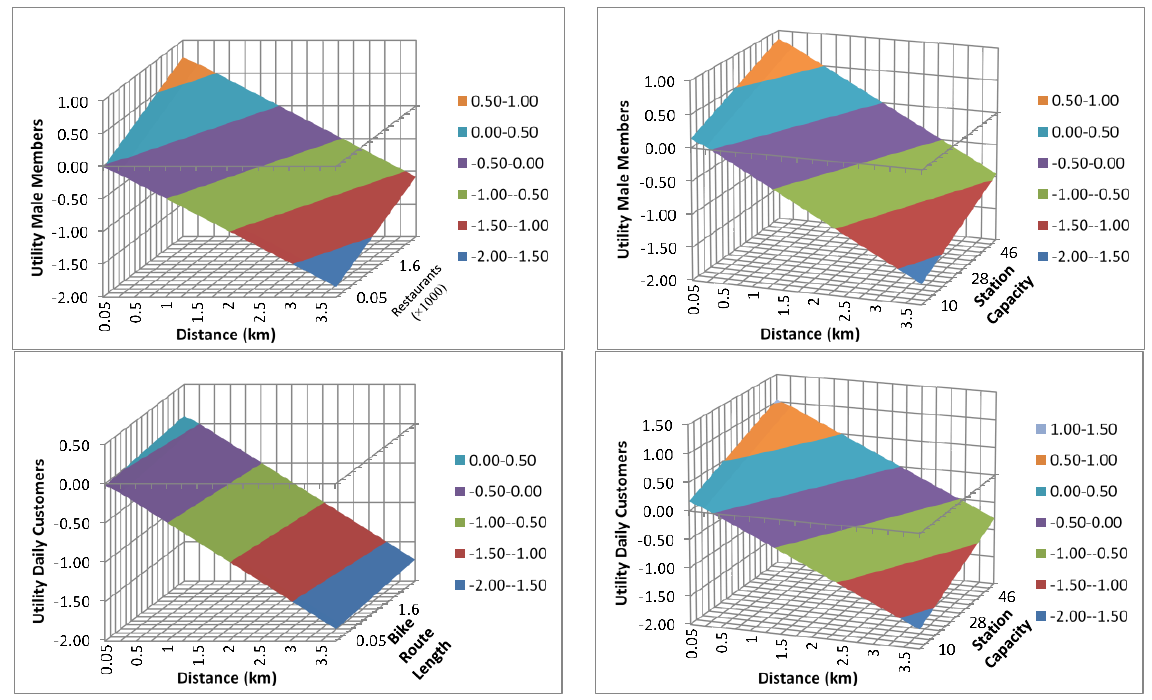
Figure 2. The Variation of Utility as a function of Distance, Bike Route Length, Number of Restaurants and Station